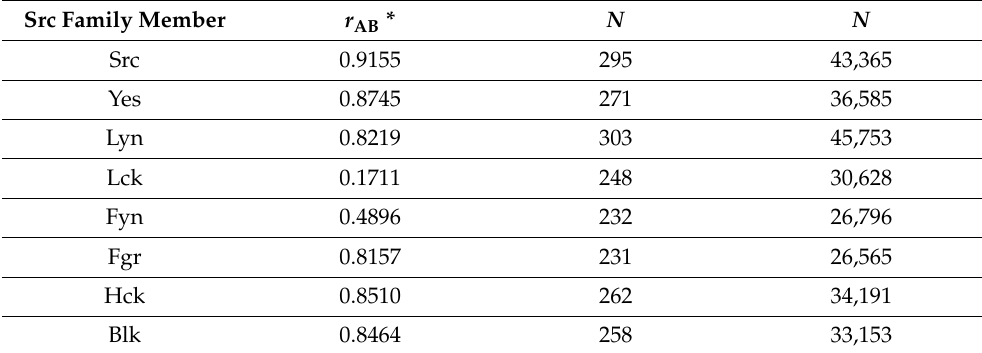
Table 2. Pearson correlation coefficients, r AB , of mirror tree analyses of coevolution of the Na + , K + -ATPase α 1 subunit and members of the Src kinase family. N is the number of common organisms, and n is the number of pairwise combinations of the common